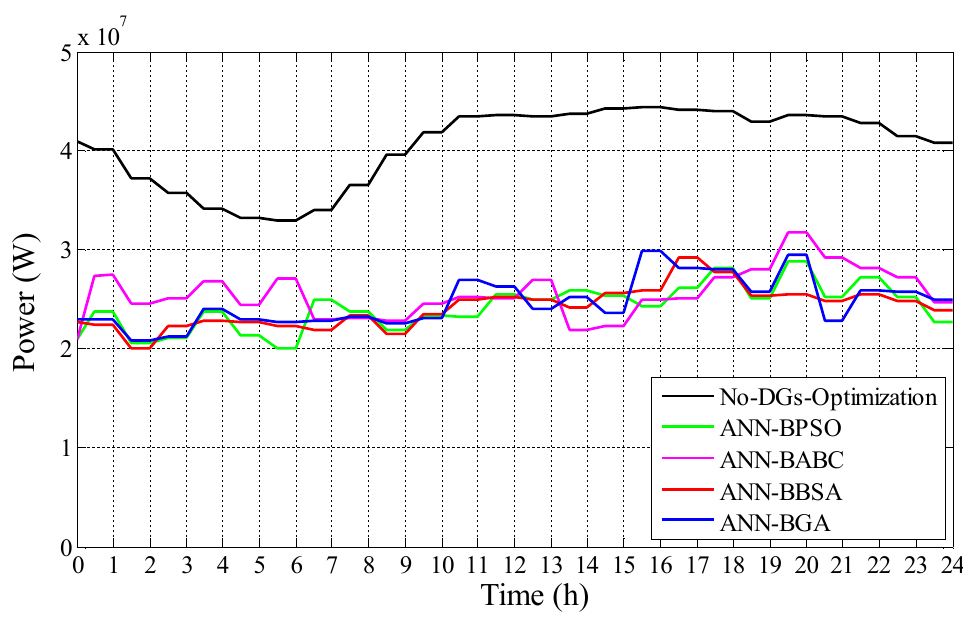
Figure 15. Original Bus1 of 14-bus IEEE test system compared to ANN-based binary optimization algorithms ANN-BPSO,